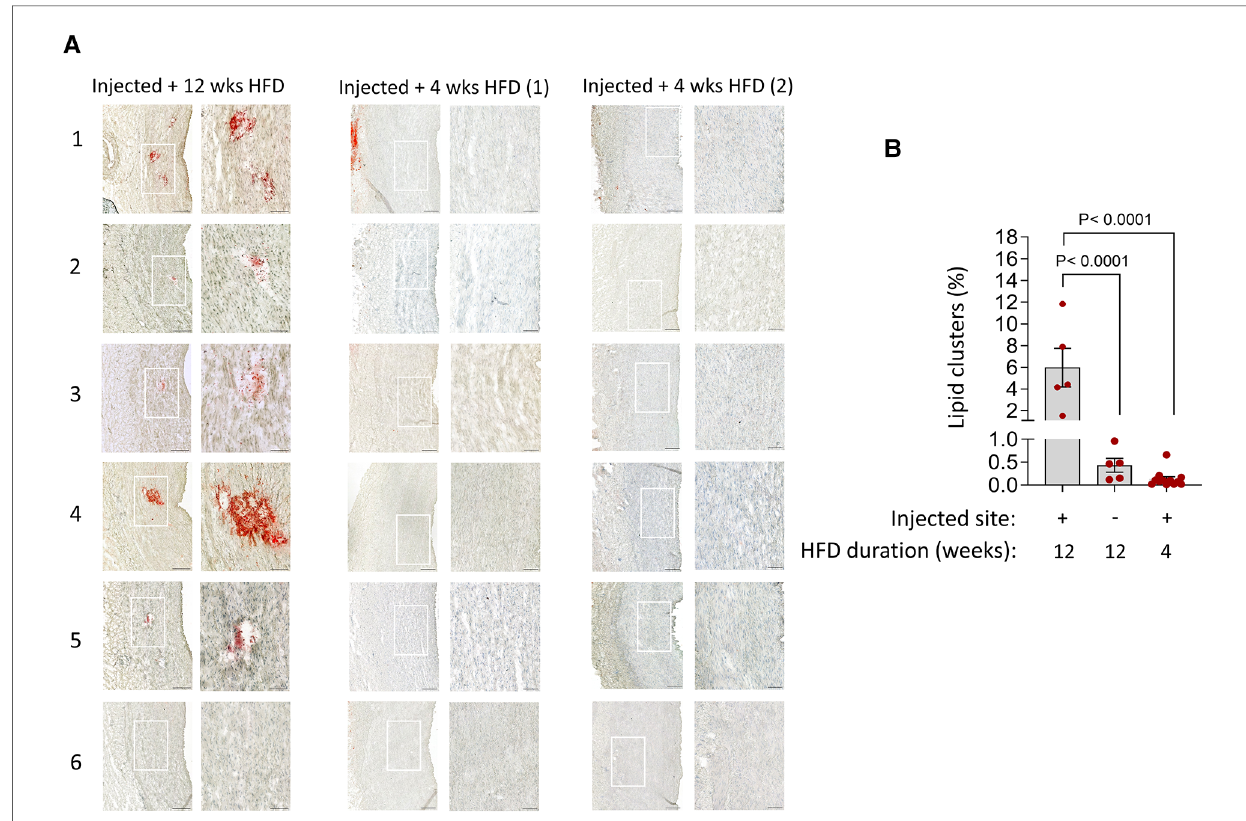
FIGURE 3 Detection of lipid clusters at the injury sites in the tunica media under prolonged hyperlipidemia. ( A ) Aortic tissue cross-sections from each injection site ( n =6) in the indicated groups, stained with ORO and counterstained with haematoxylin. The magni fi ed fi elds of view detect lipid clusters (red) in 5 out of 6 injected sites within tunica media in prolonged HFD group. No lipid clusters are seen in all 6 injection sites in both pigs under short-term 4 weeks HFD. Adventitial ORO-positive staining in random areas was not considered injury-related. Scale bars: 100 µm. ( B ) Bar charts show the quanti fi cation of the area positive for lipid clusters (mean±SEM, n =5 injected sites out of 6, **** p <0.0001 by one-way ANOVA